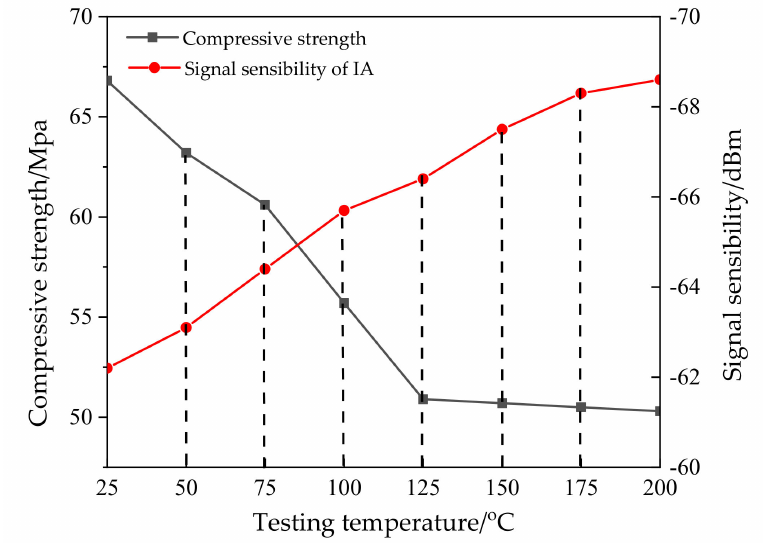
Figure 8. High-temperature resistance test results of the